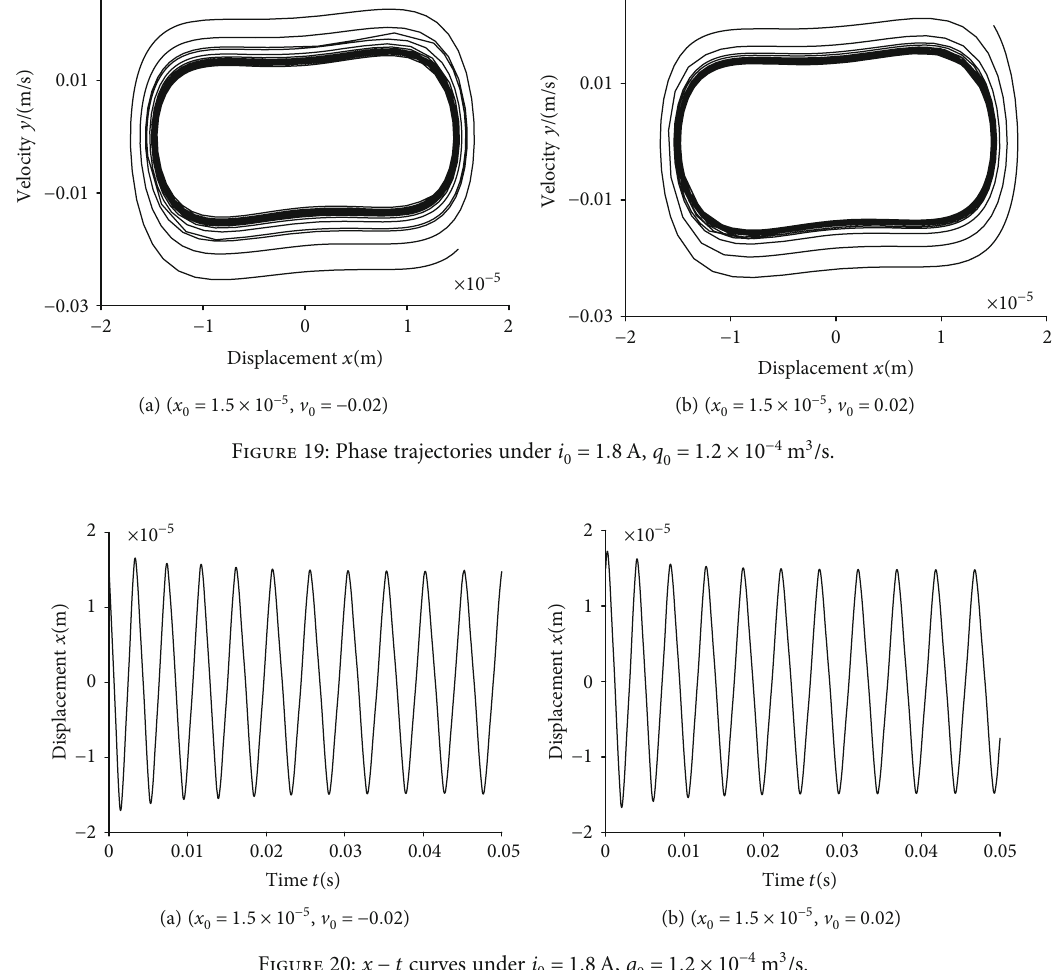
Figure 20: x − t curves under i